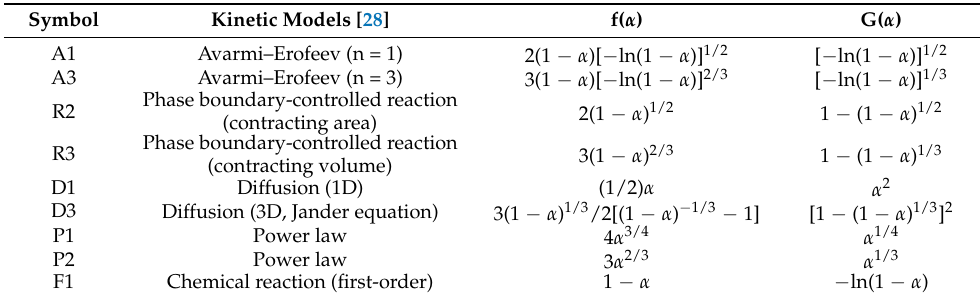
Table 1. Common kinetic model functions f ( α ) and G ( α ) used to examine gasification of graphite powder in this work.